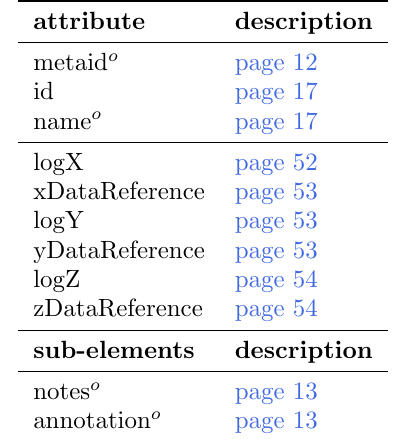
Table 2.26: Attributes and nested elements for surface. o denotes optional elements and